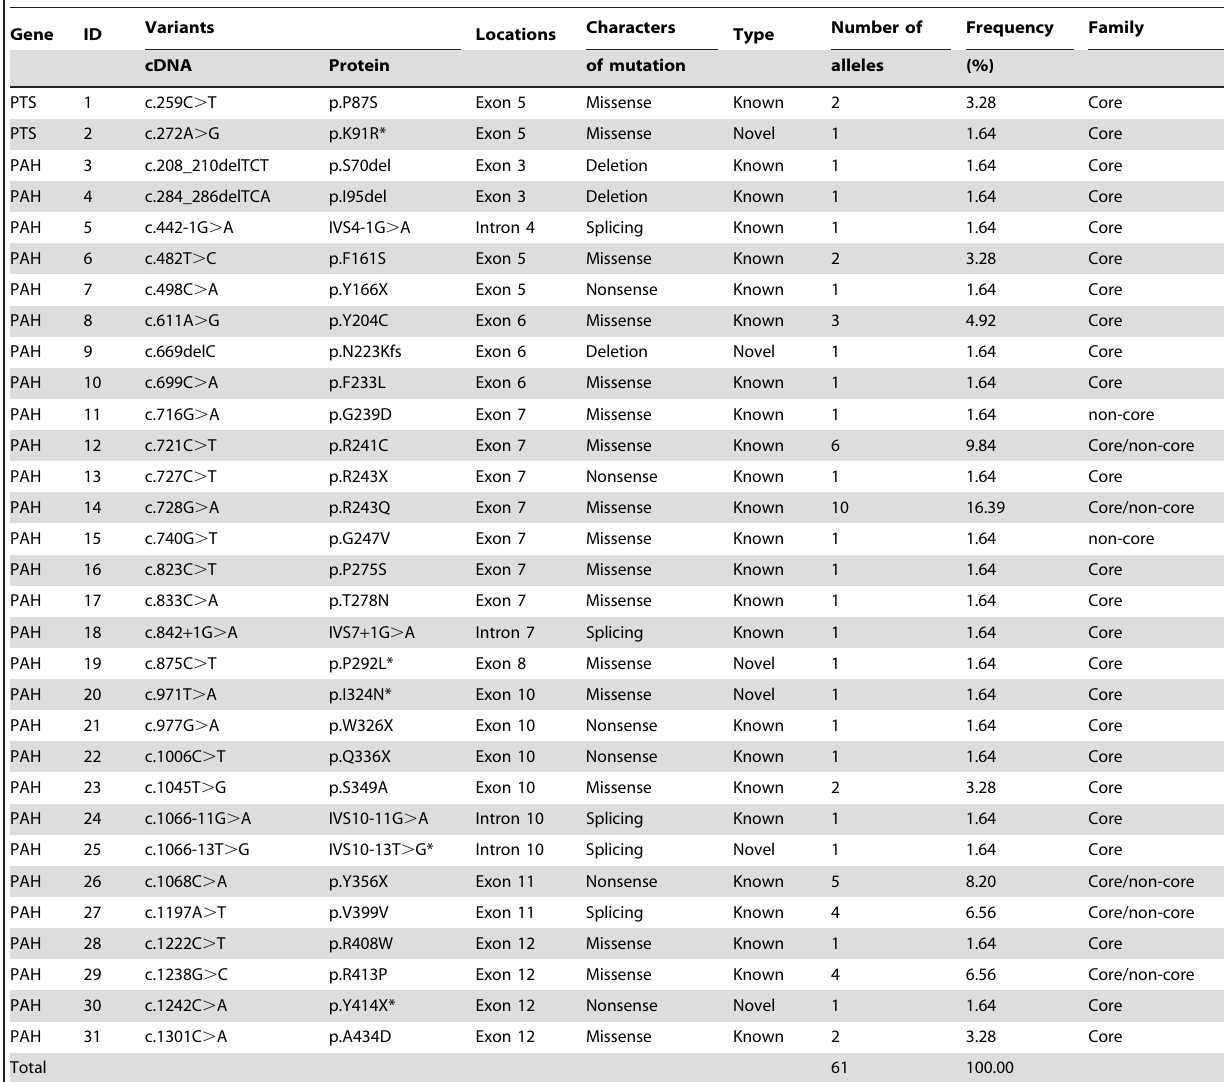
Table 1. Spectrum of PAH and PTS mutations.